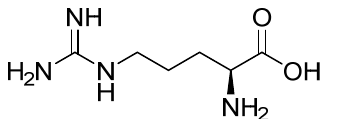
Figure 6. Schematic structure of polylysine. 2.3. Osteopontin (Bone Sialoprotein) Osteopontin is a protein encoded in humans by the SPP1 gene and is also known as bone sialoprotein (BSP). It plays a role in apoptosis processes, cell activation, and chemotaxis. However, it is primarily a potential nucleator of HAp, responsible for biomineralization and bone remodeling [131]. An interesting fact is that with the assistance of osteopontin or appropriate antibodies, it is possible to treat specific human pathologies, e.g., autoimmune disease, cancer metastasis, immune organ atrophy, and also, primarily important in this review, bone remodeling [132]. Therefore, the